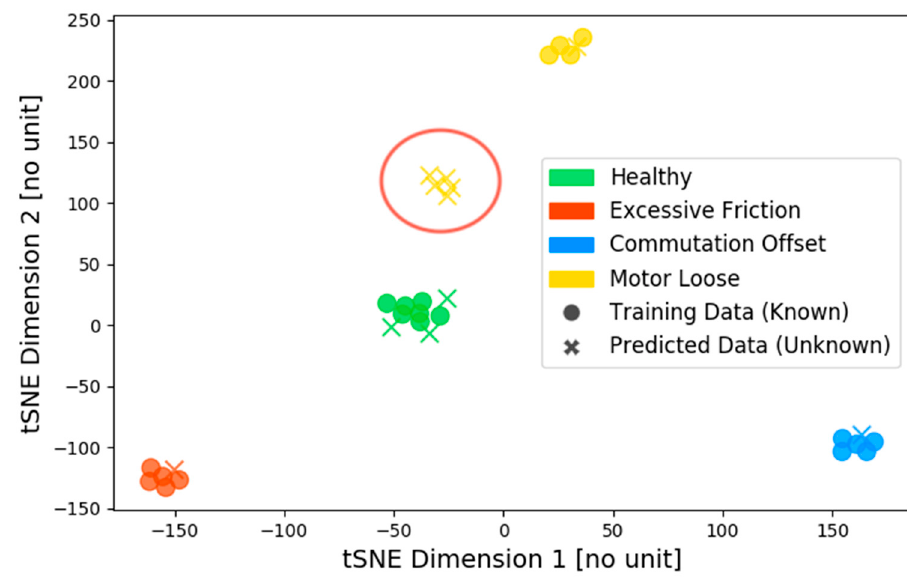
Figure 5. T-distributed stochastic neighbour embedding (tSNE) plot of training and prediction by k-means and